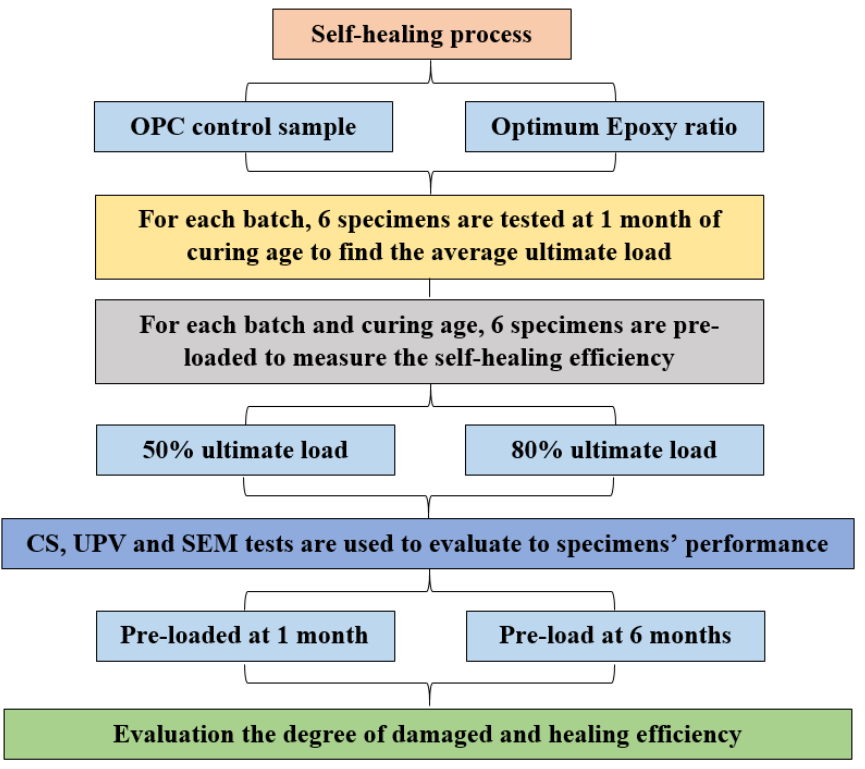
Figure 4. Self-healing evaluation procedure.